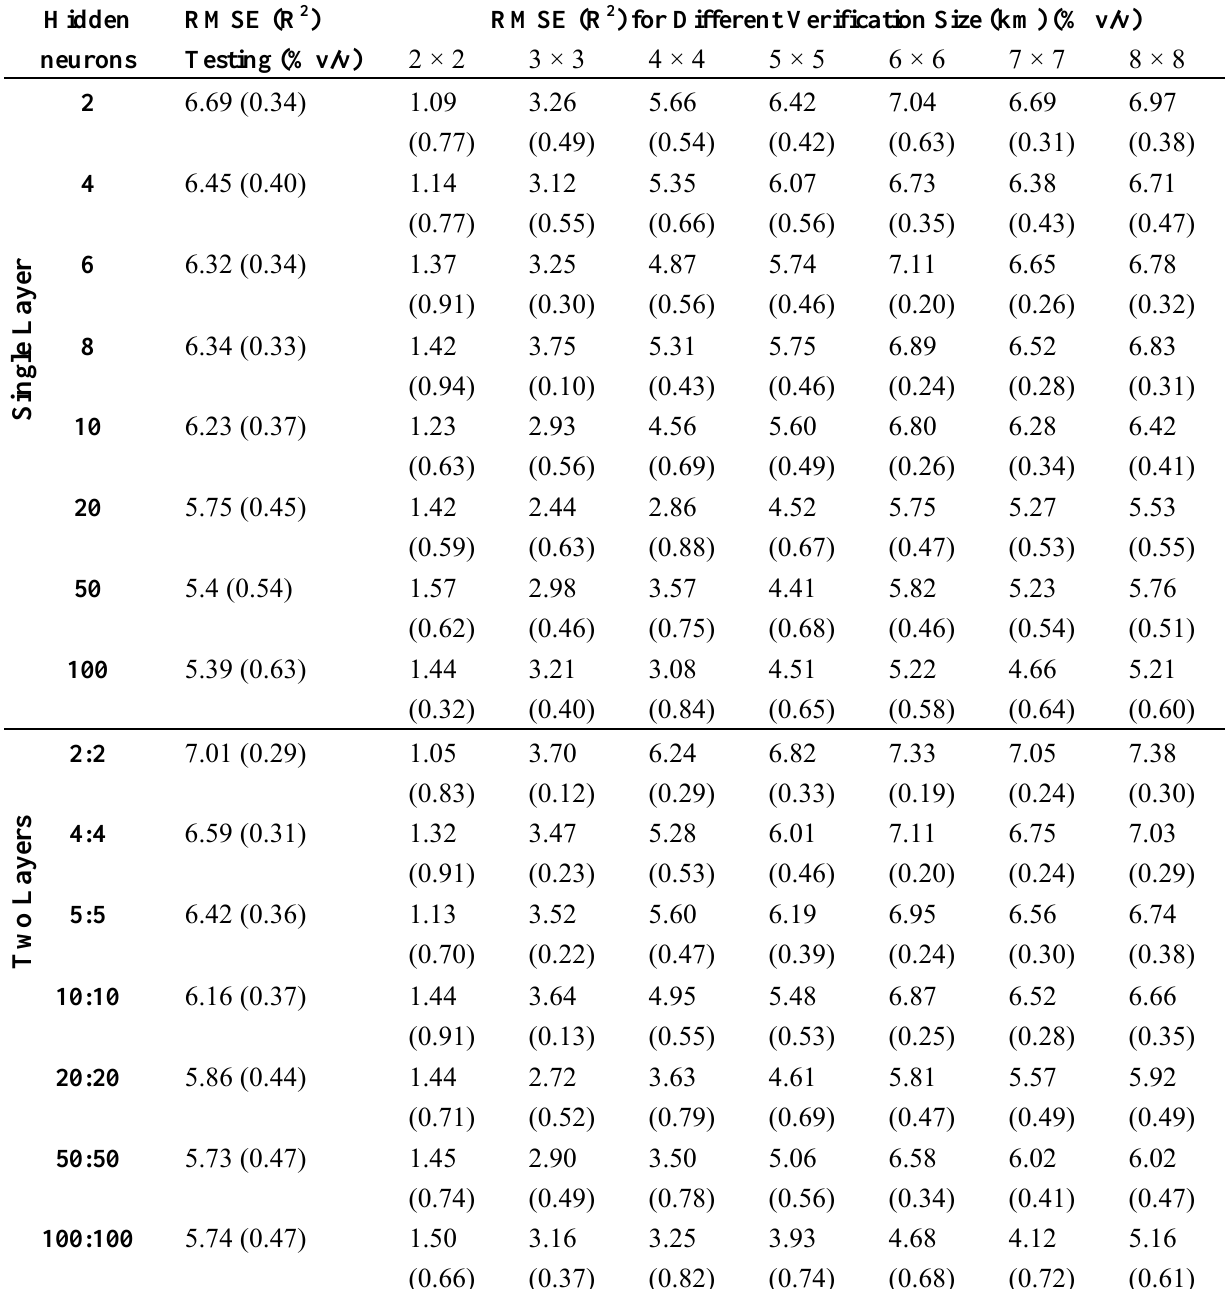
(Table 5) and TbH, TbV, NDVI and LST (Table 6). As a result of this, the optimum sub-grid size is taken to be 4 km × 4 km. Table 3. The impact on RMSE and R 2 for different numbers of hidden layers, hidden neurons and number of square grid subdivisions when using only TbH and TbV as